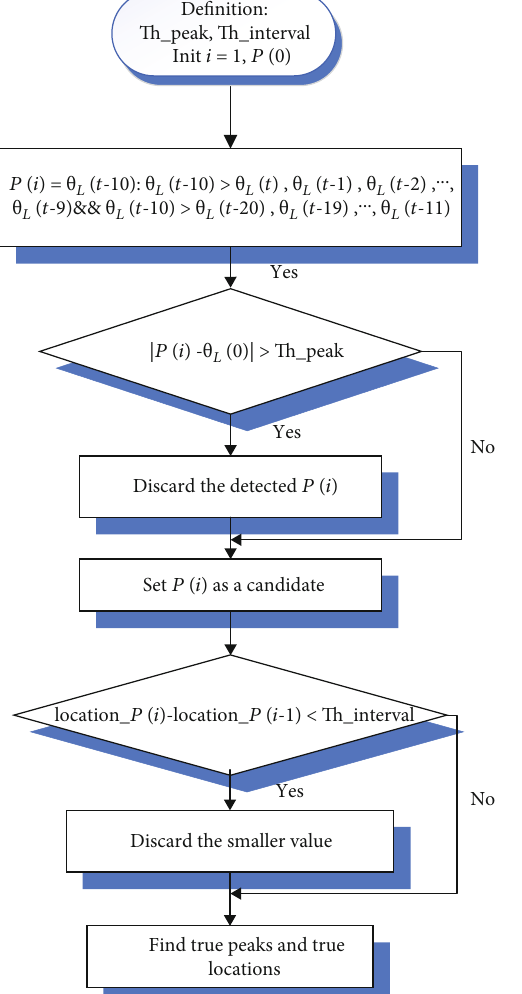
Figure 4: The fl ow chart of fi nding a peak value from the thigh pitch